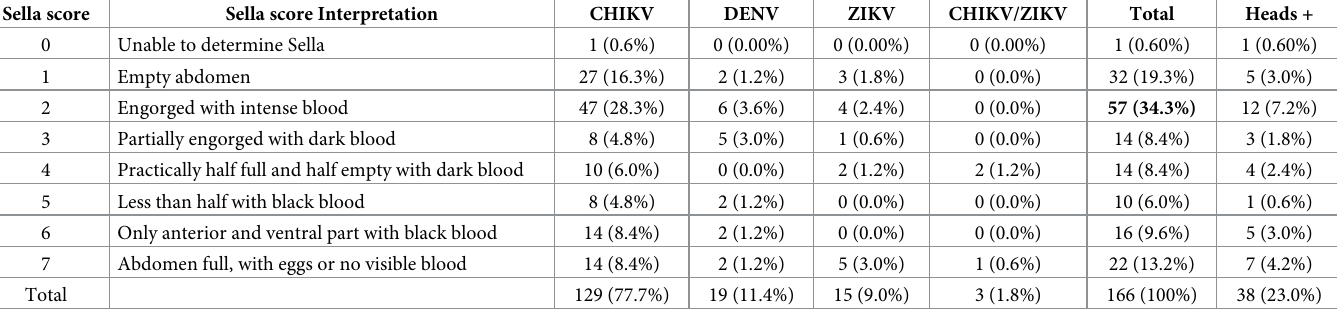
Table 3. Distribution of virus infection among Sella scores, and their relationship with positive heads from Ae . aegypti collected during the ABV transmission sea- sons of 2016 and 2017 in Yucata´n, Mexico. Sella score Sella score